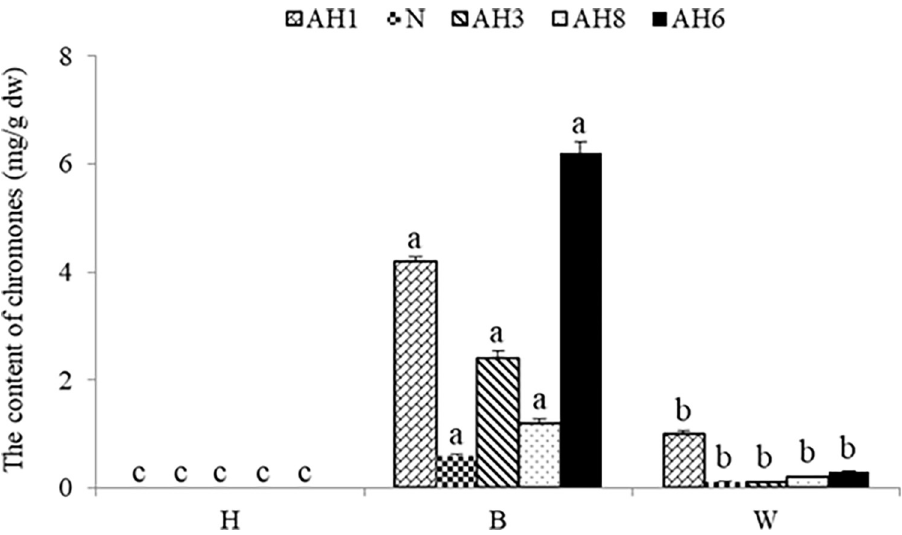
Fig 8. The contents of five chromones in the brown zone (B), wild agarwood (W), and healthy zone (H).